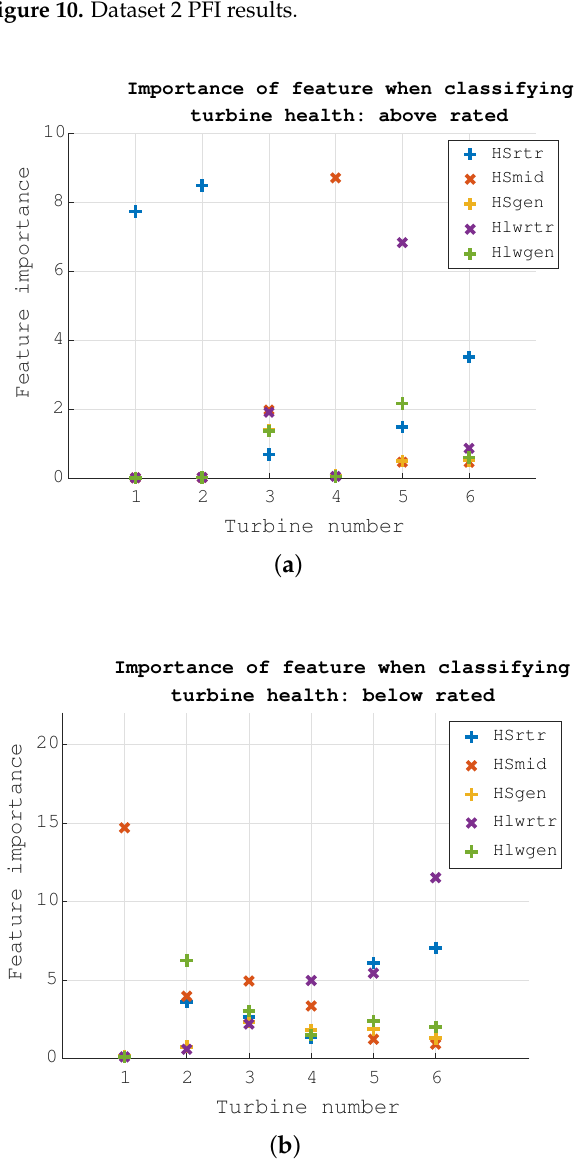
Figure 11. Dataset 2 PFI results above rated power data ( a ) and below rated power data ( b